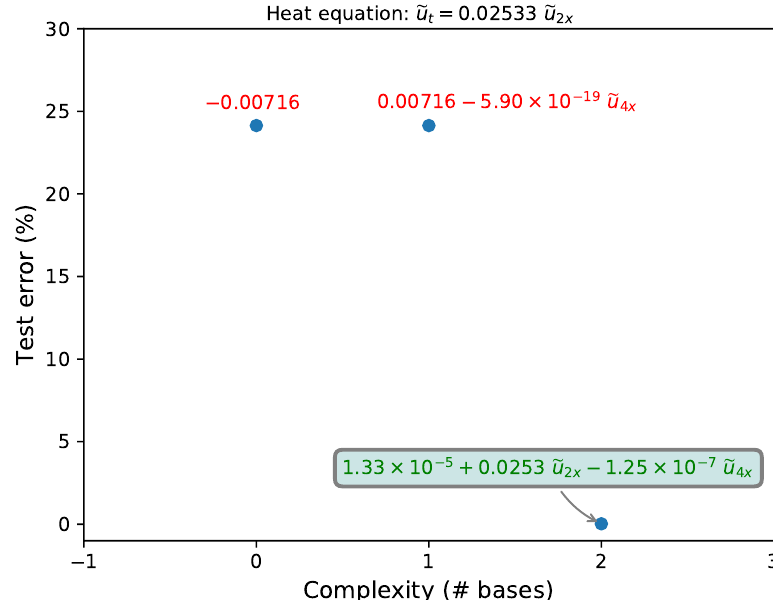
Figure 5. Predicted models with varied test error and complexity for heat